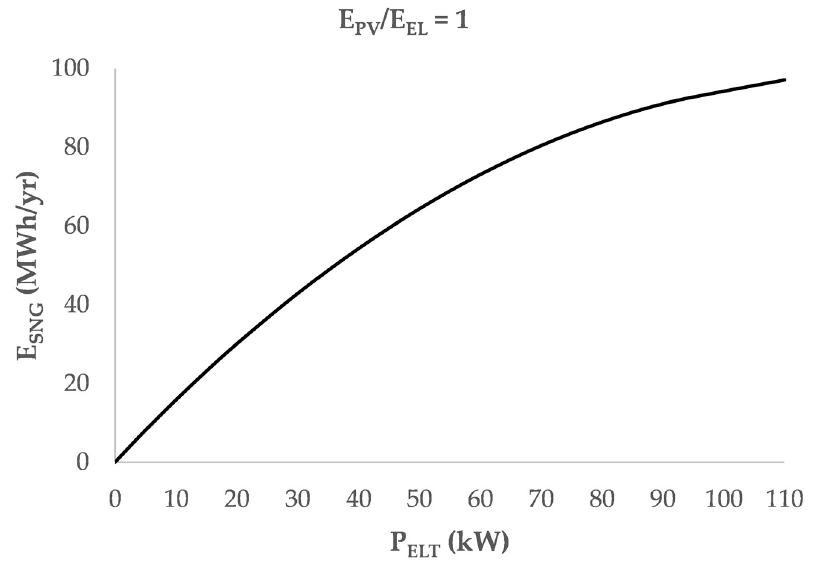
Figure 6. Annual SNG production, expressed by MWh/yr, versus the rated power of electrolyser in the scenario E PV /E EL equal to 1.